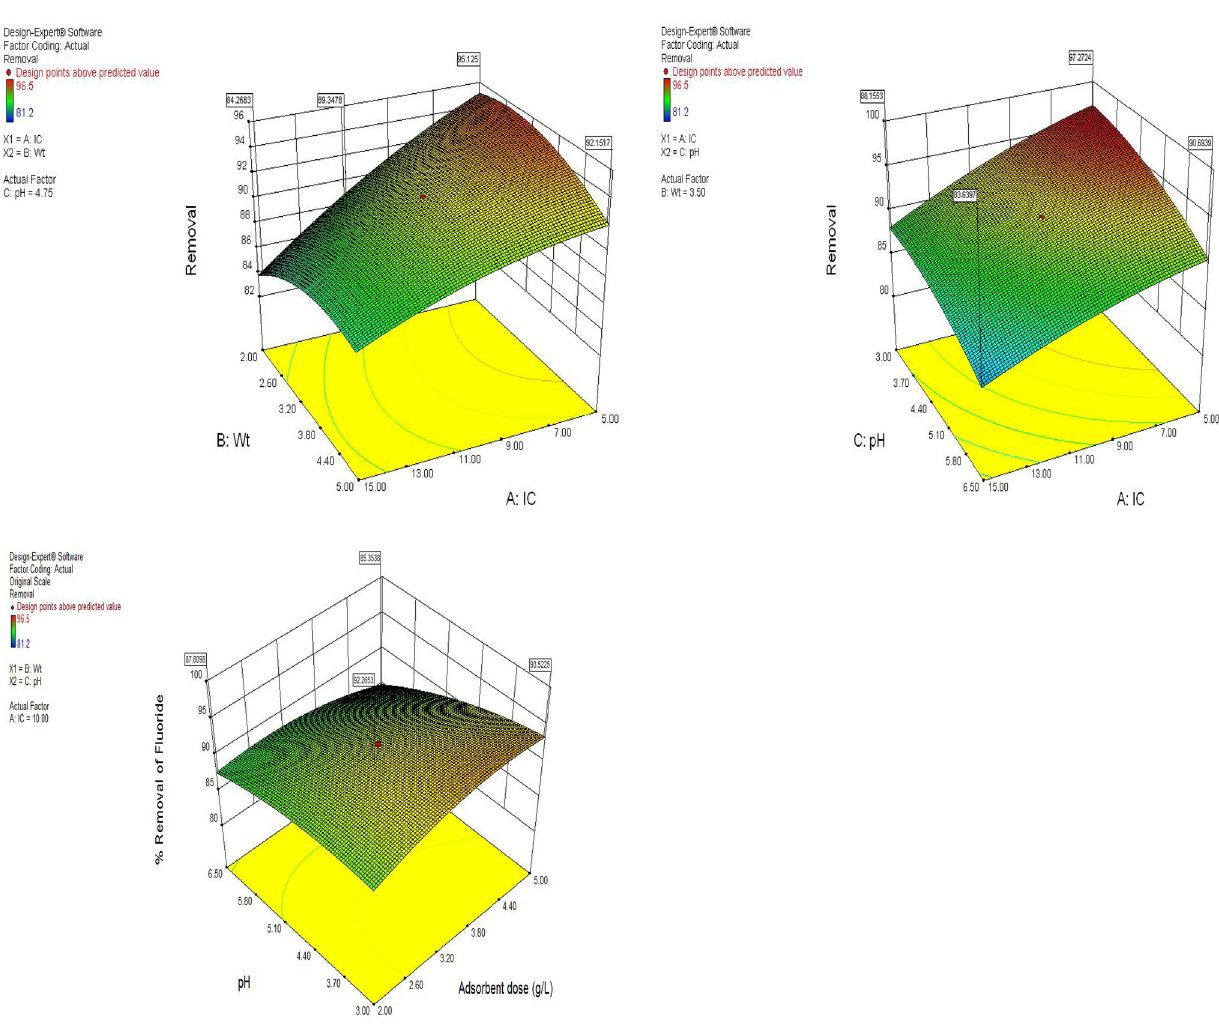
Fig. 9 a Response surface diagram of conjugated effect of adsorbent dose and initial concentration of fluoride for defluoridation study using CCSFP. b Response surface diagram of conjugated effect of pH